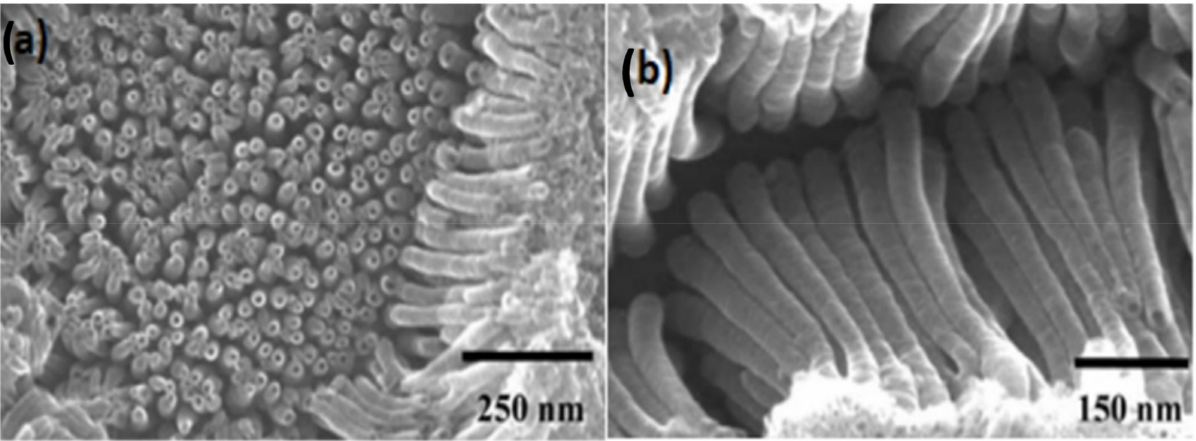
Figure 16. SEM image of TiO 2 ‘coral reef’ nanotube structures formed at 50 V in CH 3 COOH + 0.5 wt.% NH 4 F solution ( a ) inside and ( b ) outside. Reprinted with permission from Ref. [160]. Copyright 2005